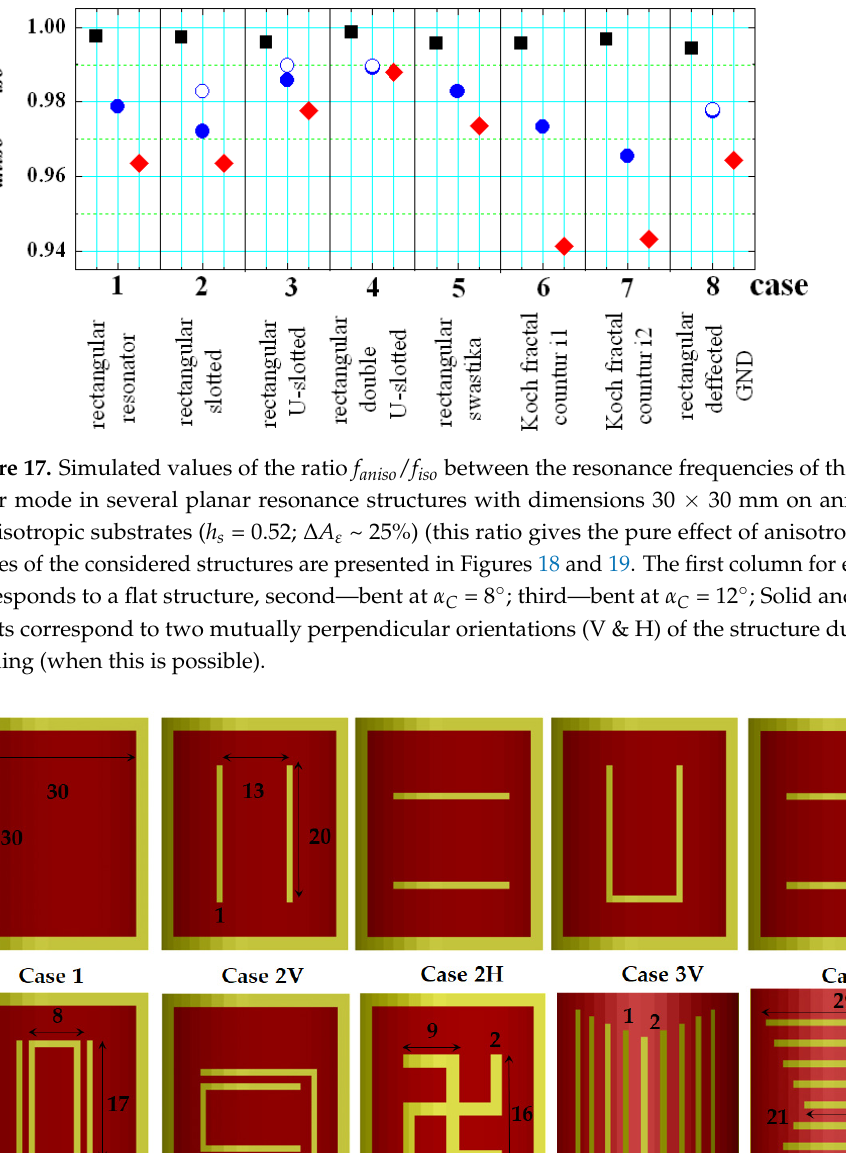
Figure 18. Simulated values of the ratio f bent_iso / f flat_iso between the resonance frequencies of the low- est-order mode in several planar resonance structures with dimensions 30 × 30 mm on isotropic substrates ( h s = 0.52; Δ A ε ~ 25%) (this ratio gives the pure effect of bending). The shapes of the con- sidered structures are presented in Figures 19/20. The first column for each case corresponds to a Figure 19. Top view of several resonance structures (bent at α C = 8°) with dimensions in mm: Case flat structure, second—bent at α C = 8°; third—bent at α C = 12°; Solid and hollow points correspond 1—resonator (30 × 30); Case 2—resonator with two slots (V—vertical orientation; H—horizontal in mm: Case 1—resonator (30 × 30); Case 2—resonator with two slots (V—vertical to two mutually perpendicular orientations (V & H) of the structure during the bending (when orientation); Case 3—resonator with U-shaped slot (V&H); Case 4—resonator with double U- this is possible). orientation; H—horizontal orientation); Case 3—resonator with U-shaped slot (V&H); shaped slot (V&H); Case 5—resonator with swastika slot; Case 8—resonator with a defected Case 4—resonator with double U-shaped slot (V&H); Case 5—resonator with swastika ground (V&H). slot; Case 8—resonator with a defected ground